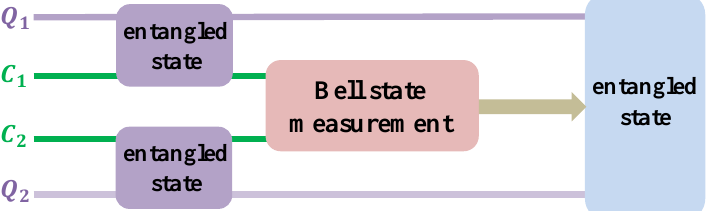
Figure 1. Sketch of entanglement swapping. Initially, Q 1 is entangled with C 1 and Q 2 with C 2 . Bell state measurement on the cavities C 1 and C 2 will project Q 1 and Q 2 to one of four orthogonal maximum entangled